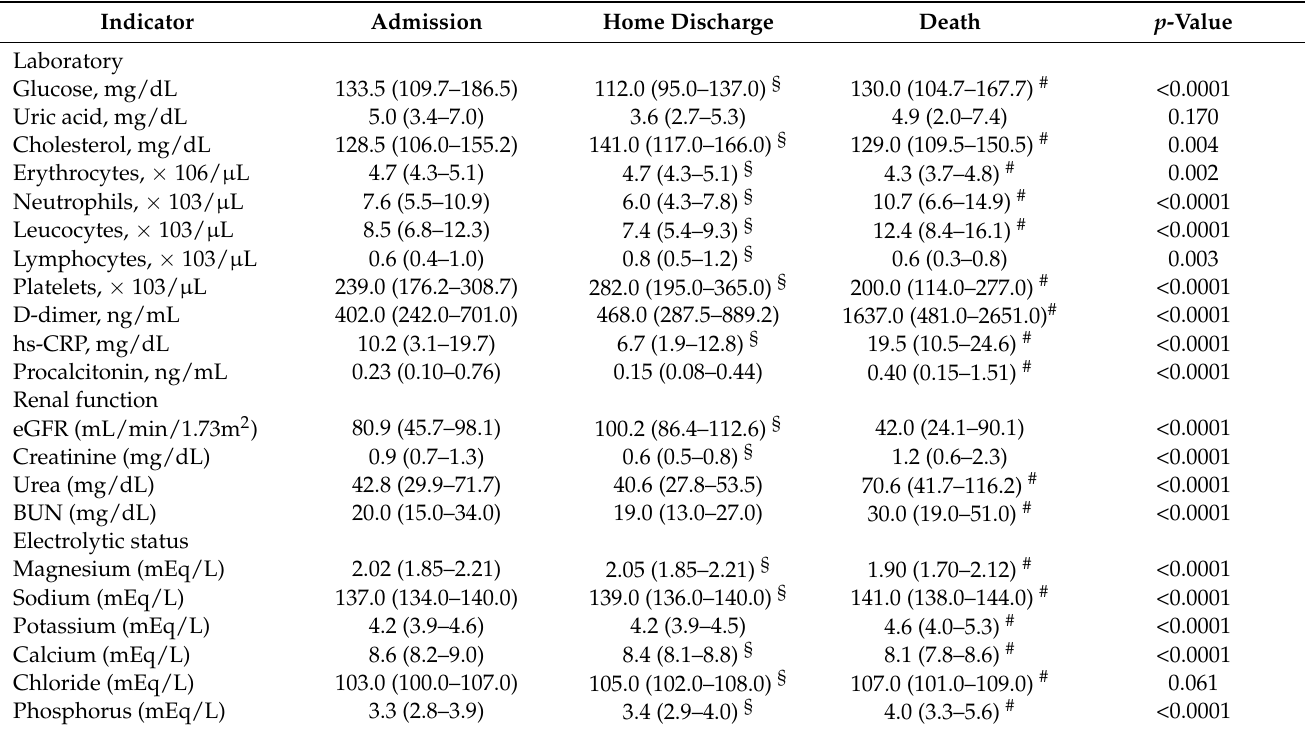
Table 2. Comparisons of the laboratory measures, renal function, and electrolyte status between admission, home discharge, and death ( n =